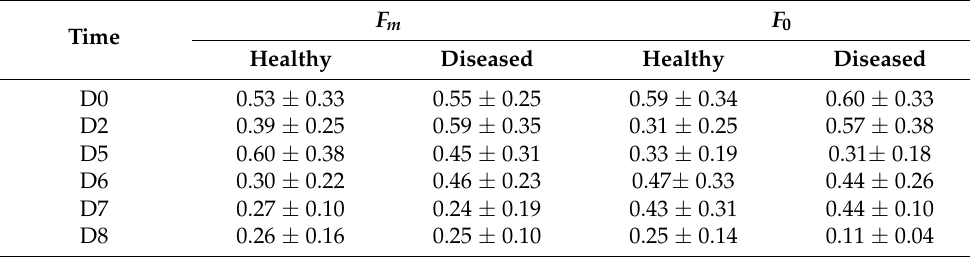
Figure 1. Example of chlorophyll fluorescence images of Arabidopsis thaliana inoculated by a bacteria, at day 2, pot 19, a healthy pot (inoculated with water): ( a ) F m maximum fluorescence and ( b ) F 0 minimum fluorescence. The histograms ( c , d ) are the associated frequency distribution of pixel counts inside the region of interest drawn in a solid yellow line in ( a , b ), respectively. The dashed blue line in the histograms is the fit with a normal probability density function (pdf). Table 1. Mean ± the standard deviation of four p-values associated with the D’Agostino test of normality in the limb of the Arabidopsis thaliana inoculated by a bacteria for F m maximum fluorescence and F 0 minimum fluorescence. D0, ..., and D8 are the six days of the acquisition of chlorophyll fluorescence images.